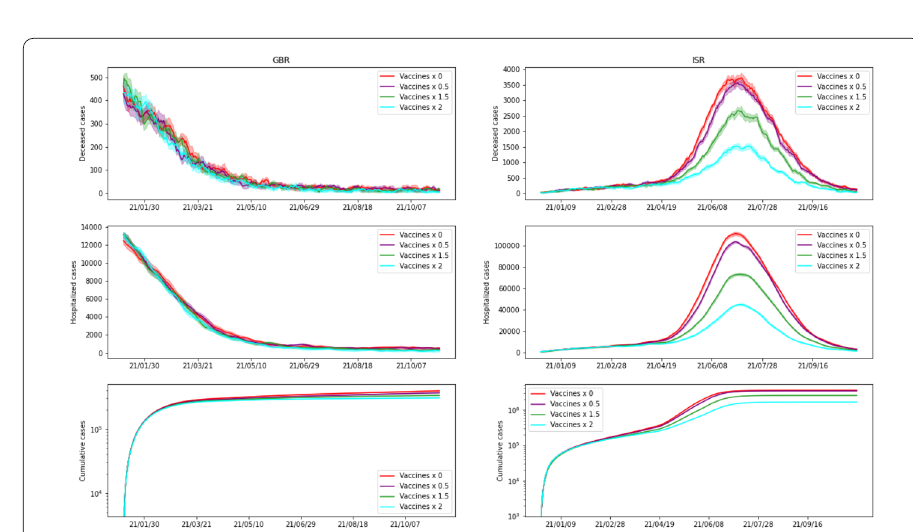
Figure 11 Scenario7 . Comparison of simulations with different numbers of vaccines administered. Parameter k is a factor multiplying the average daily number of vaccines according to the available data for each country. Vaccine efficacy is the one previously estimated, as well as the remaining parameters. We present cumulative cases, hospitalized and deceased for both GBR (on the left) and ISR (on the right). Note that the simulation starts only on the first day of the vaccination campaign for each